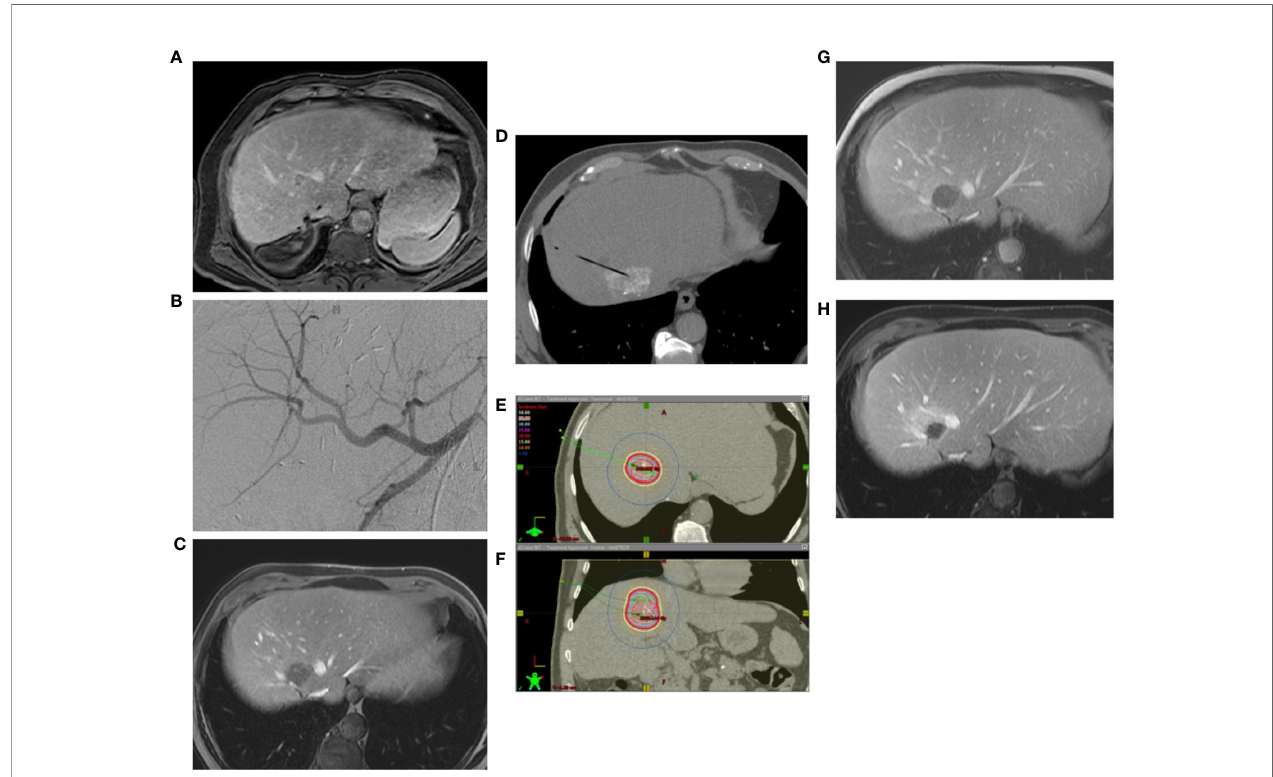
FIGURE 1 | (A) Renewed solitary CRC-metastasis after multiple surgical metastasectomies, sometimes with complicated postoperative course until sepsis. (B) The dif fi cultly located new metastasis between the hepatic veins in S VIII has been initially transartelically chemoembolized (TACE). (C) Post-interventional contrast-enhanced MRI shows subtotal devascularisation of the target lesion. (D) Interstitial brachytherapy was performed sequentially. Lipiodol labelling from TACE was used for navigation of the brachytherapy applicator. (E) The image shows the isodose distribution in the axial plane. (F) Isodose distribution in the coronary plane. (G) contrast enhanced MRI reveals an excellent local tumor control after 3 months. (H) After 6 months the tumor cavity shrinks in time, there is still no recurrence, only perifocal postradiogenic